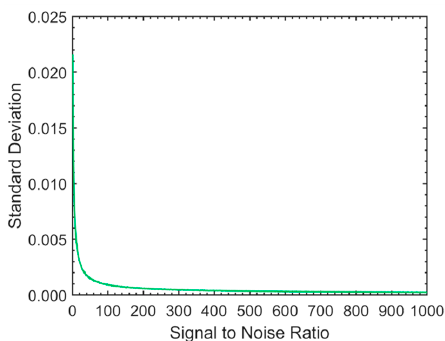
Figure 12. The standard deviation of the CCs at various noise levels. There was an asymptotic increase in the standard deviation of the CCs when the SNR decreased through the introduction of AWGN.